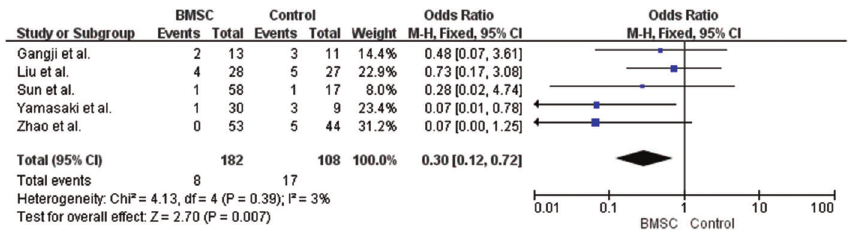
Figure 3 - Forest plot for the arthroplasty incidence after bone marrow stem cell implantation.